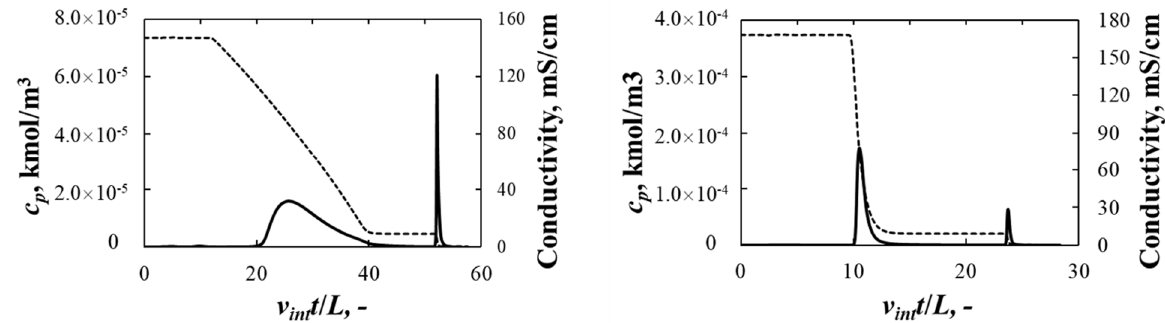
Figure 6. Example of bind-elute test performed with BSA, on the left the gradient elution and on the right the isocratic elution. The continuous line is the outlet protein concentration, while the dashed line is the experimental conductivity profile.